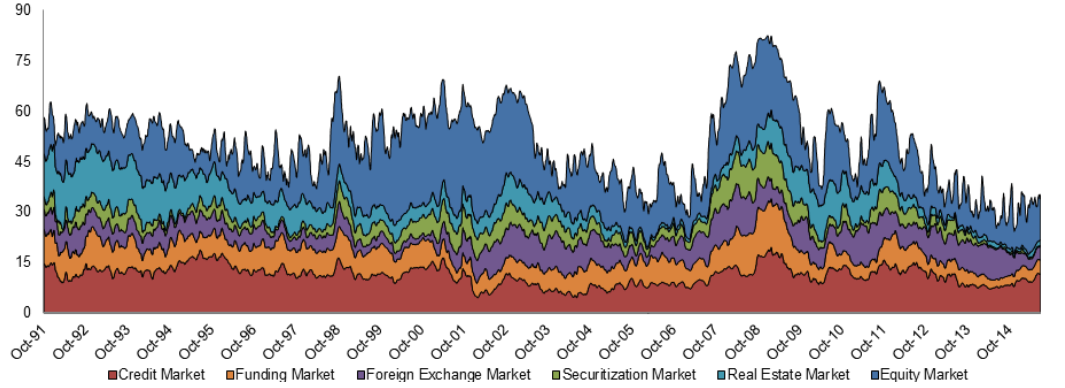
Figure 5. CFSI decomposed into market